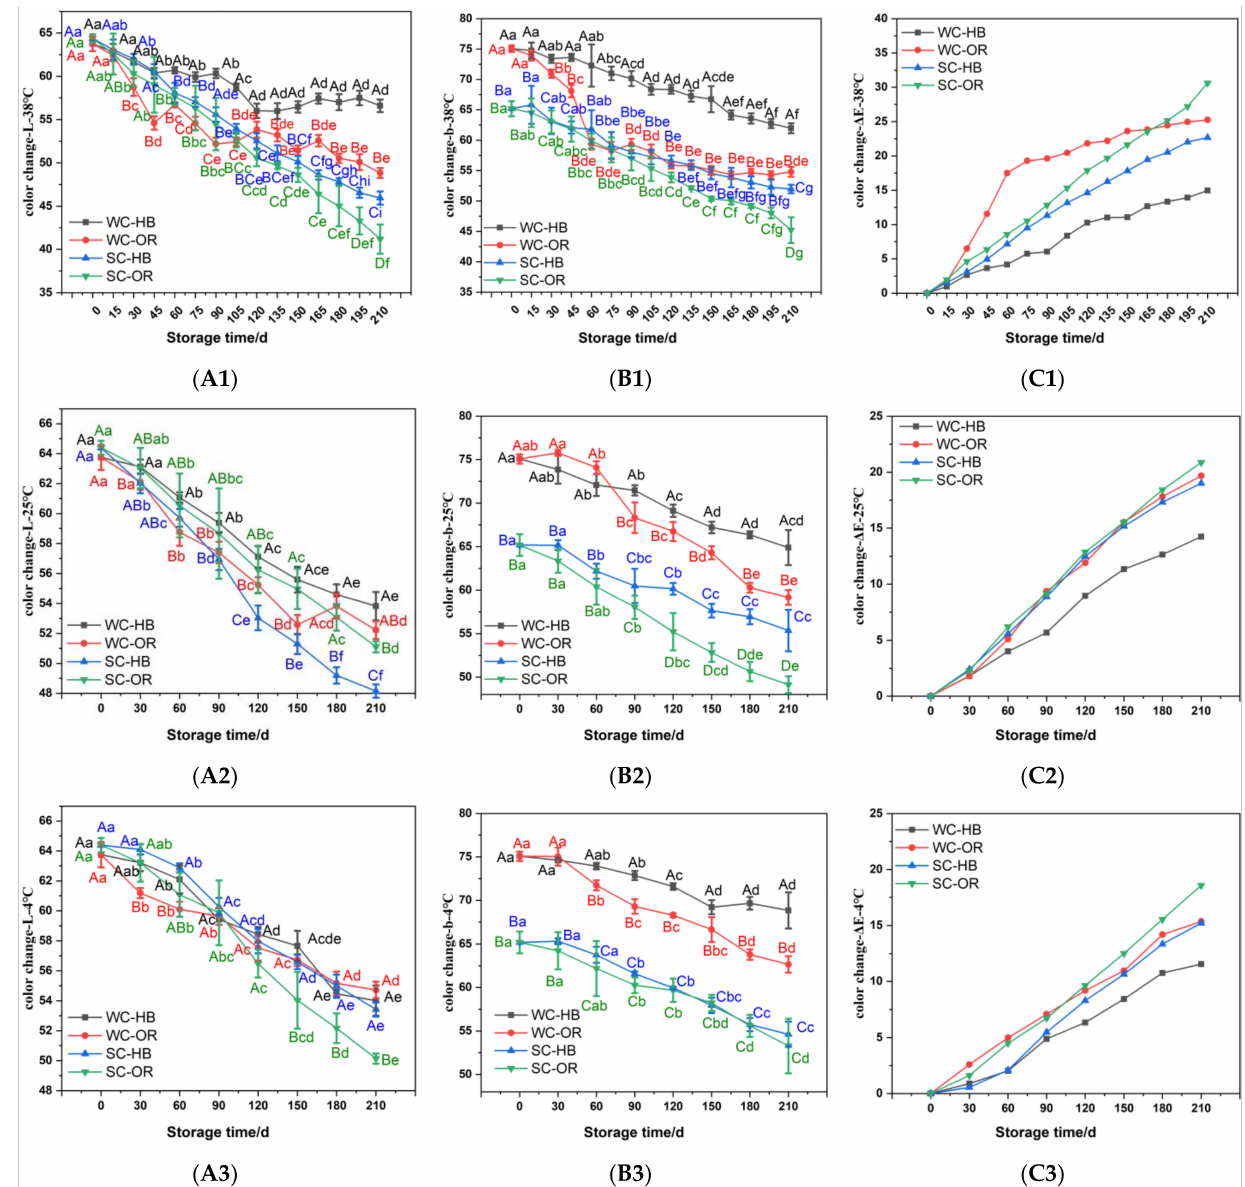
Figure 3. The L * ( A1 – A3 ), b * ( B1 – B3 ), and ∆ E ( C1 – C3 ) color values of the fresh corn packaged with HB and OR composite films at three storage temperatures from 0 to 210 d. Different capital letters (A–D) indicate significant differences ( p < 0.05) between different treatments at the same storage time. Different lowercase letters (a–i) indicate significant differences ( p < 0.05) between different storage times for the same treatment. Duncan’s test was used to analyze differences between groups. WC-HB indicates waxy corn packaged with high-barrier nylon/nylon/PP composite film. WC-OR indicates waxy corn packaged with ordinary nylon/nylon/PP composite film. SC-HB indicates sweet corn packaged with high-barrier nylon/nylon/PP composite film. SC-OR indicates sweet corn packaged with ordinary nylon/nylon/PP composite film. L * ( A1 – A3 ), b * ( B1 – B3 ), and ∆ E ( C1 – C3 ) indicate that the color values of brightness, yellow-blue, and the total color difference calculated according to the color values,